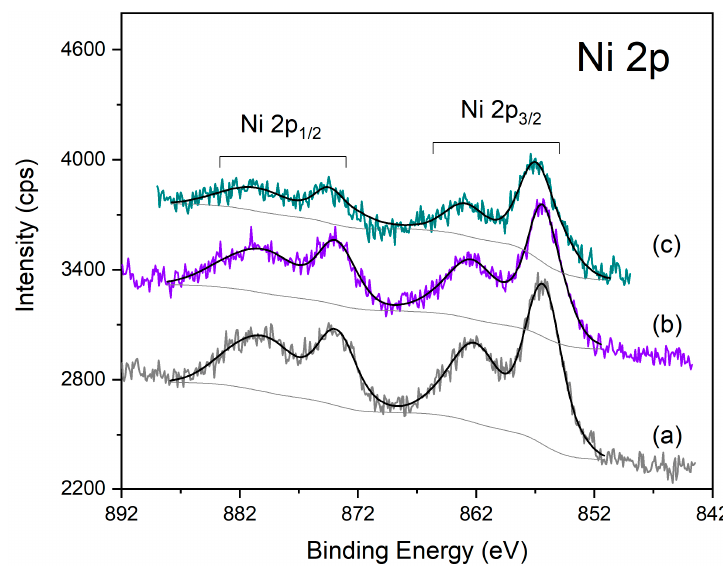
Figure 8. XPS spectra of the different Ni-Al 2 O 3 catalysts in the Ni 2p region: ( a ) Ni-Al 2 O 3 , ( b ) HPW/Ni-Al 2 O 3 ; ( c ) Ni-Al 2 O 3 /Cs 2.5 .